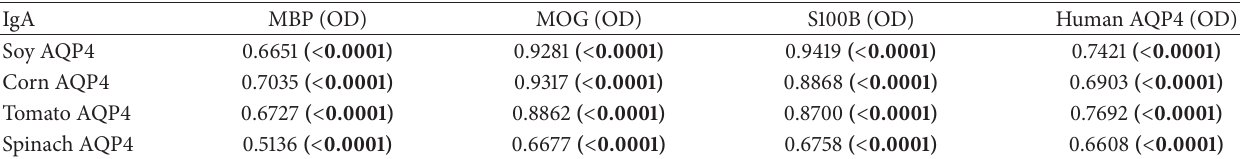
Table 3: Results of the simple linear regression between each pair of lgA isotypes of the food proteins and brain proteins in RRMS patients. The first number in each cell presents corresponding Pearson’s correlation coefficient and the second number in parentheses presents its 𝑝 value. Small 𝑝 values (less than 0.05) are marked in bold. Note that 𝑅 2 values of these regressions are the squares of Pearson’s correlation coefficients.